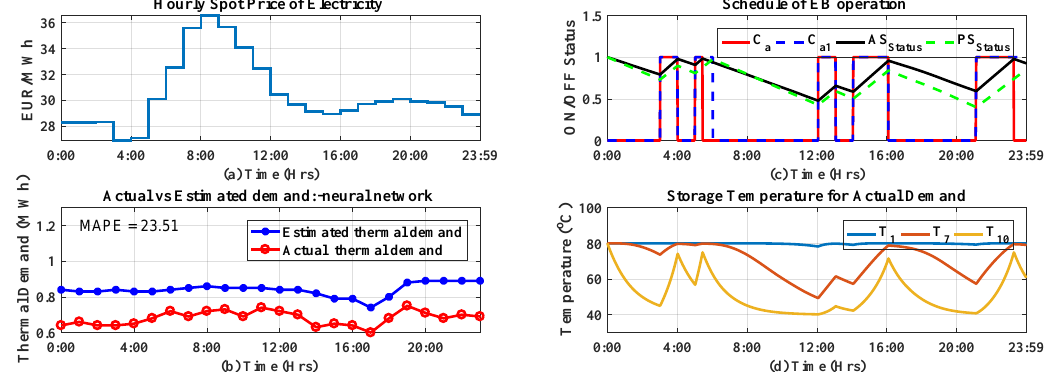
Figure 17. ( a ) Spot price of electricity in Denmark region DK1 on 23 March 2017; ( b ) actual and estimated thermal demand on 23 March; ( c ) estimated EB schedule based on estimated demand ( C a 1 ), estimated EB storage status ( PS status ), and actual schedule of EB based on actual demand ( C a ), and actual EB storage status ( AS status ); ( d ) storage temperature of various layers for actual demand and